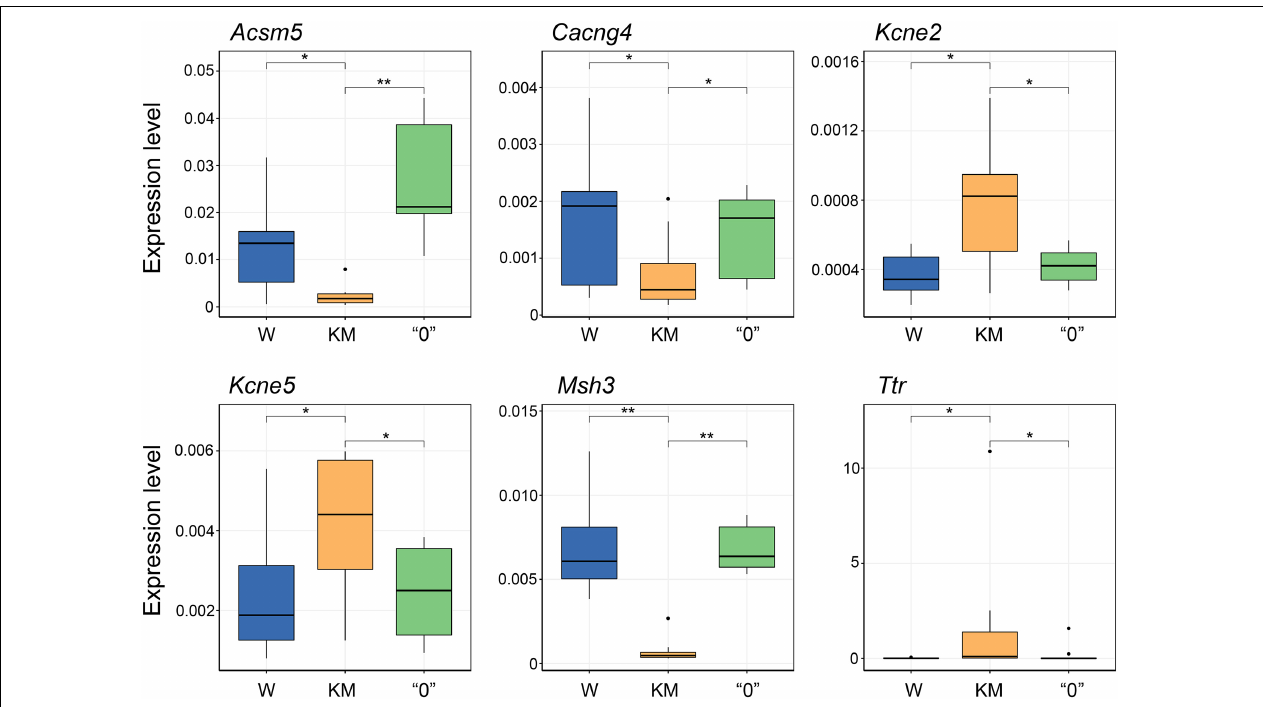
FIGURE 5 | qPCR validation of gene expression changes initially observed through RNA-seq analysis. Expression levels determined by the 2 − dCt equation, including normalization of the genes of interest levels to a housekeeping gene ( Ywhaz ) for each group of samples. Expression levels were estimated for no fewer than 6 rats. * p < 0.05, ** p < 0.01, Kruskal-Wallis test with post hoc analysis.